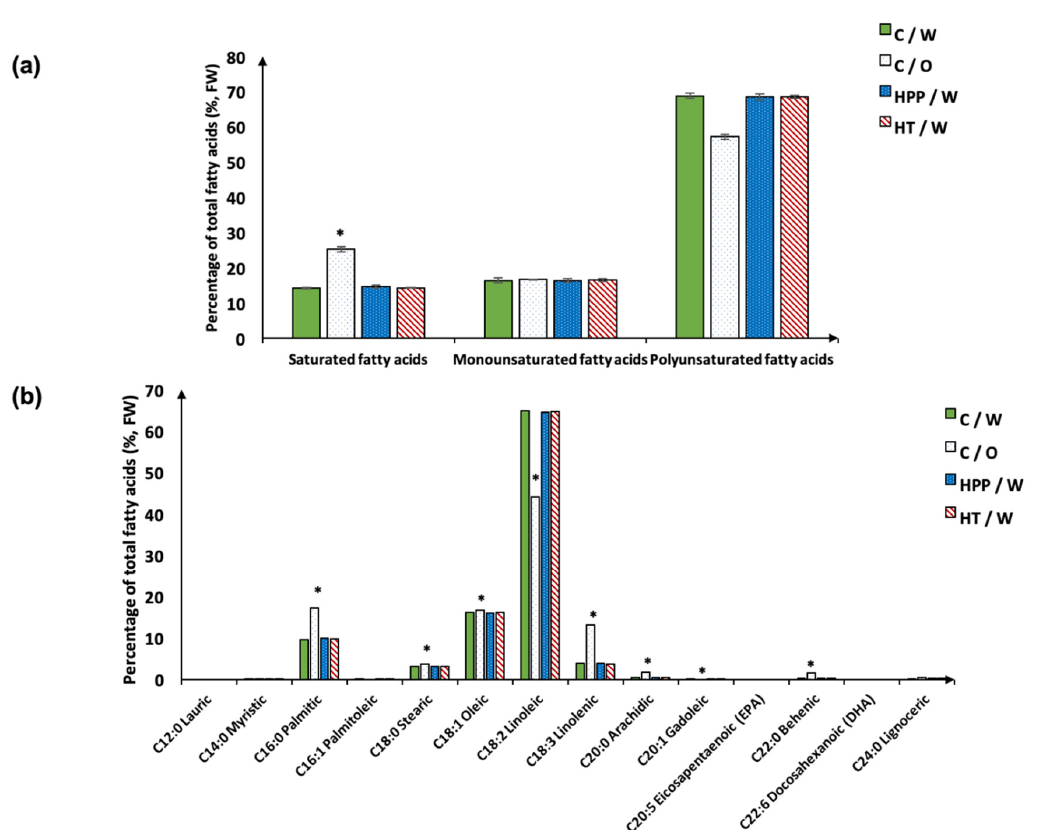
Figure 5. Total fatty acid profile: percentage of saturated fatty acids, monounsaturated fatty acids, and polyunsaturated fatty acids ( a ) and percentage of individual fatty acid ( b ) in Concord grape purees made via different processes. Denotation of “*” indicates significant difference among different treatments ( p < 0.001). FW: fresh basis; C/O: control puree made without seeds; C/W: control puree made with seeds; HPP/W: HPP(600 MPa, 3 min) puree made with seeds; HT/W: HT (63 °C, 3 min) puree made with seeds.